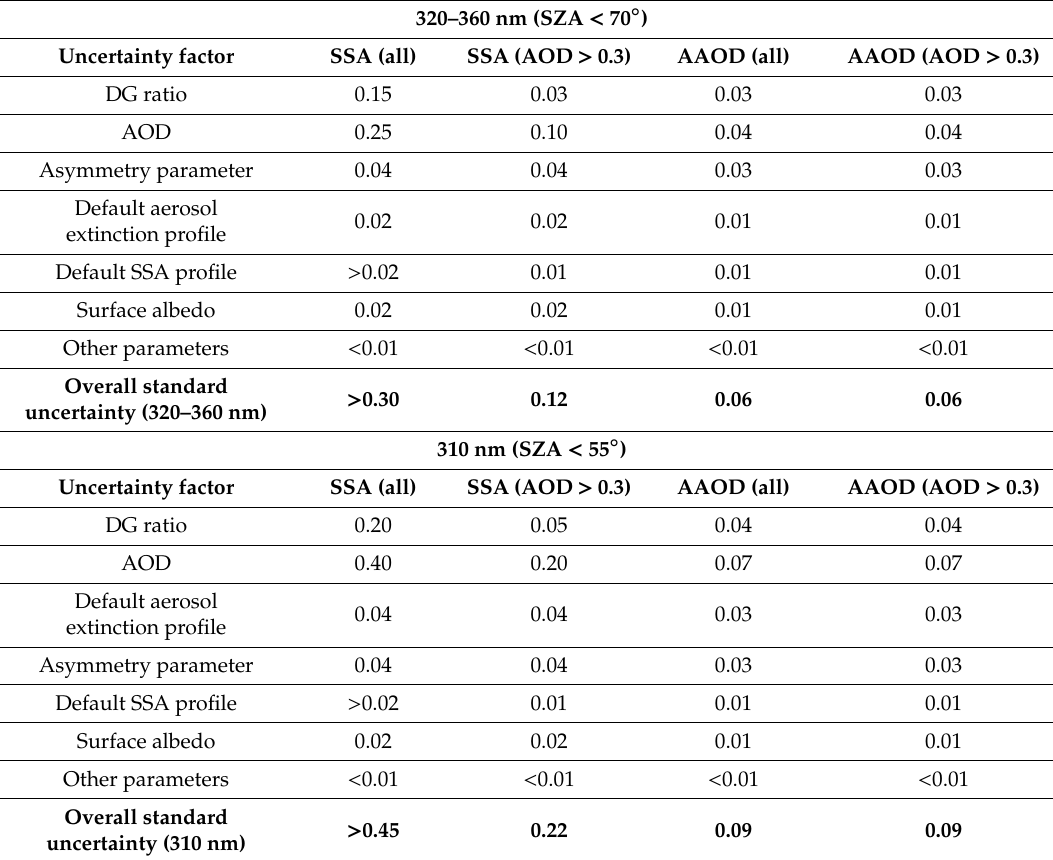
Table 1. Standard uncertainties for single scattering albedo (SSA) and AAOD at 320–360 nm. SZA: solar zenith angle; DG: direct and the global UV irradiance. The overall standard uncertainties are highlighted in